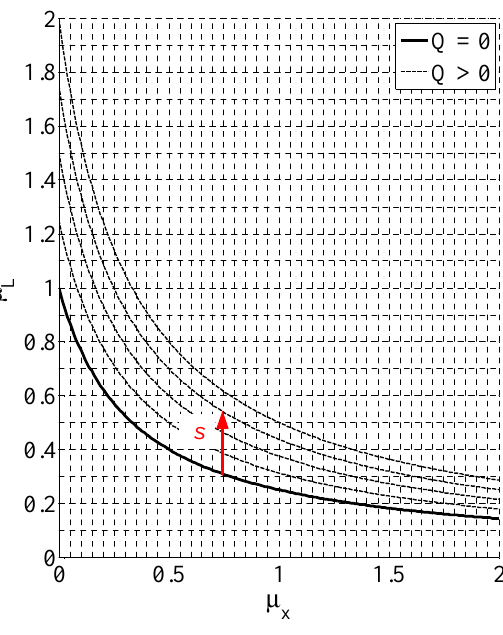
Figure 9: Example of the relation between µ L and µ x for the CBV model.